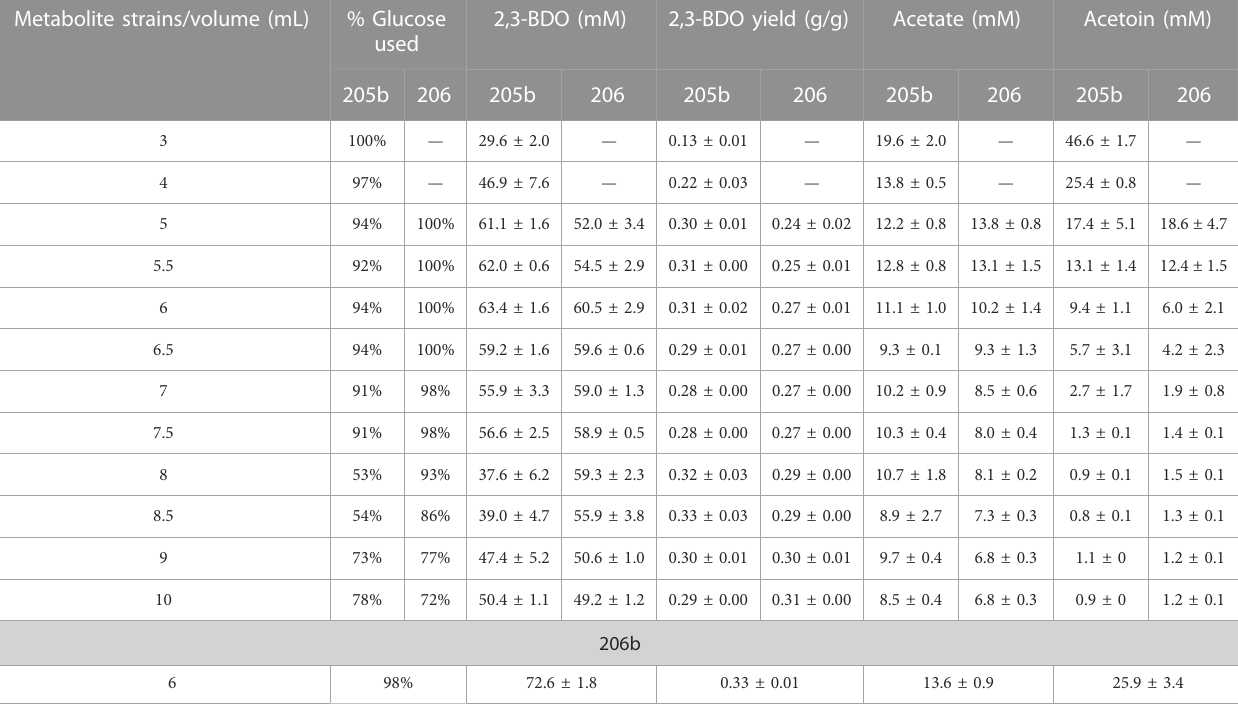
TABLE 3 Key metabolite pro fi les of engineered strains with (LS205) and without (LS206) an ack deletion under different fermentation volumes. Metabolite strains/volume